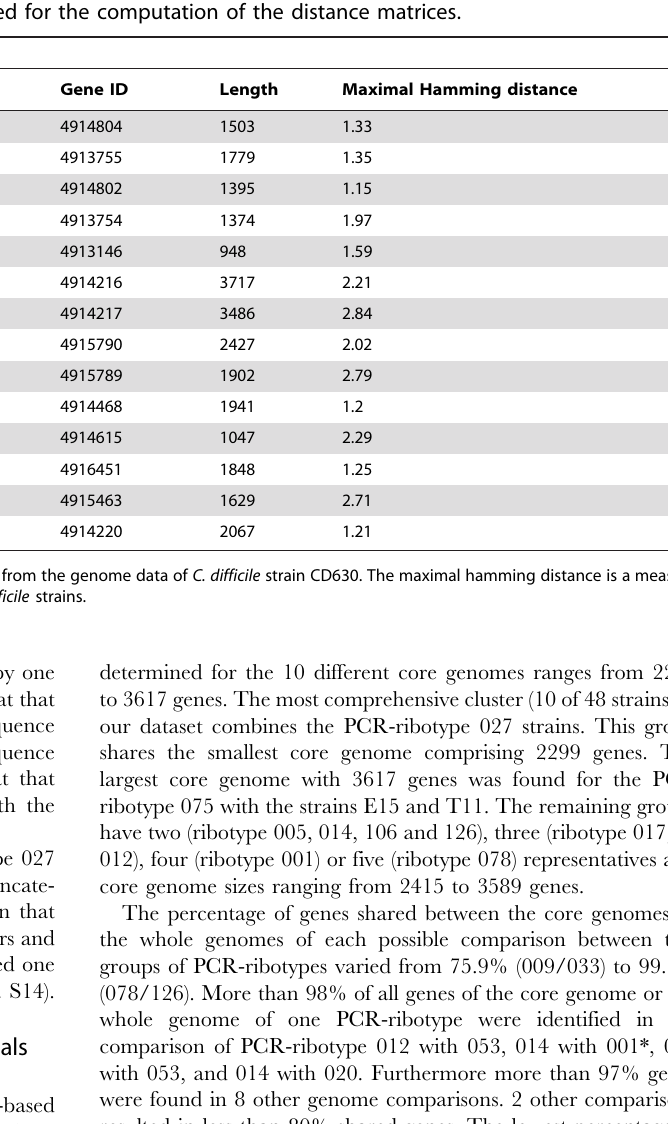
Table 4. Characteristics of the 14 conserved genes used for the computation of the distance matrices.